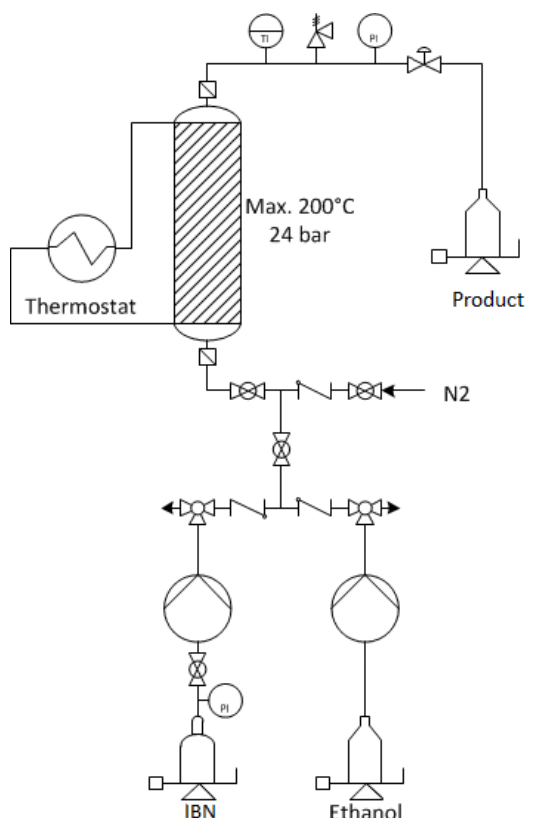
Figure 3. Flow sheet of the continuous flow reactor system to process isobutylene (IBN) and ethanol.